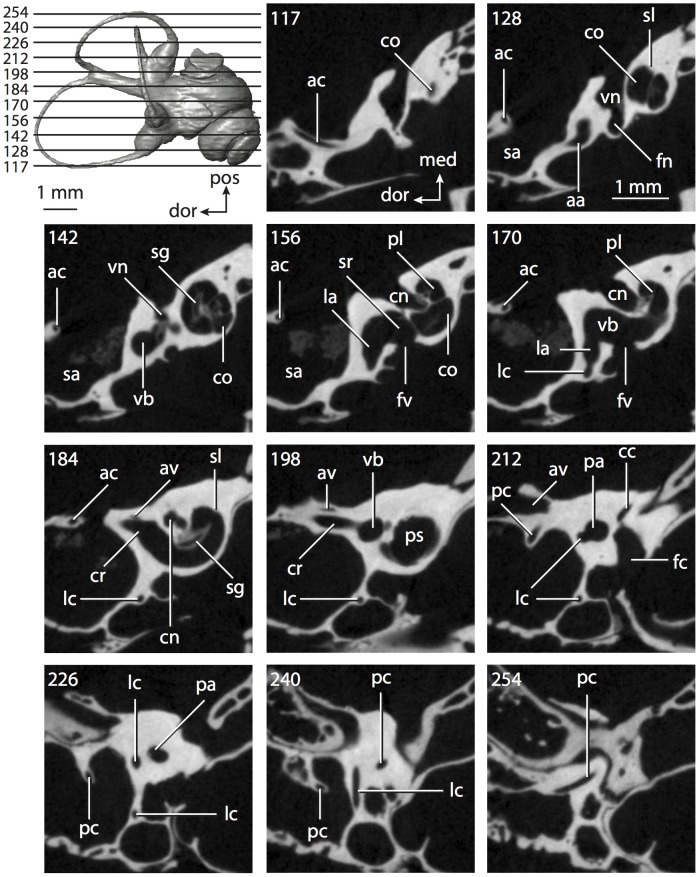
CT slices through ear region ofSylvilagus floridanus.Abbreviations listed at the end of the Materials and Methods section.